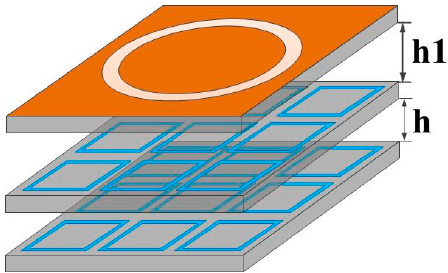
Figure 9. Complementary loop FSS integrating with HS-FSMSE (The orange and blue parts represent metal, the grey represents substrates).